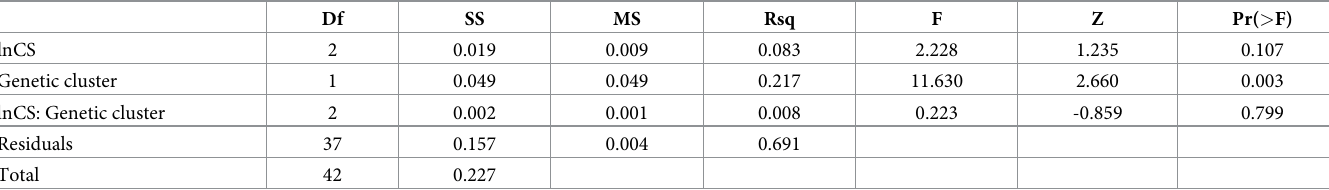
Table 2. Association of skull shape with size (lnCS), genetic cluster and their interaction. All the results are based on Procustes ANOVA